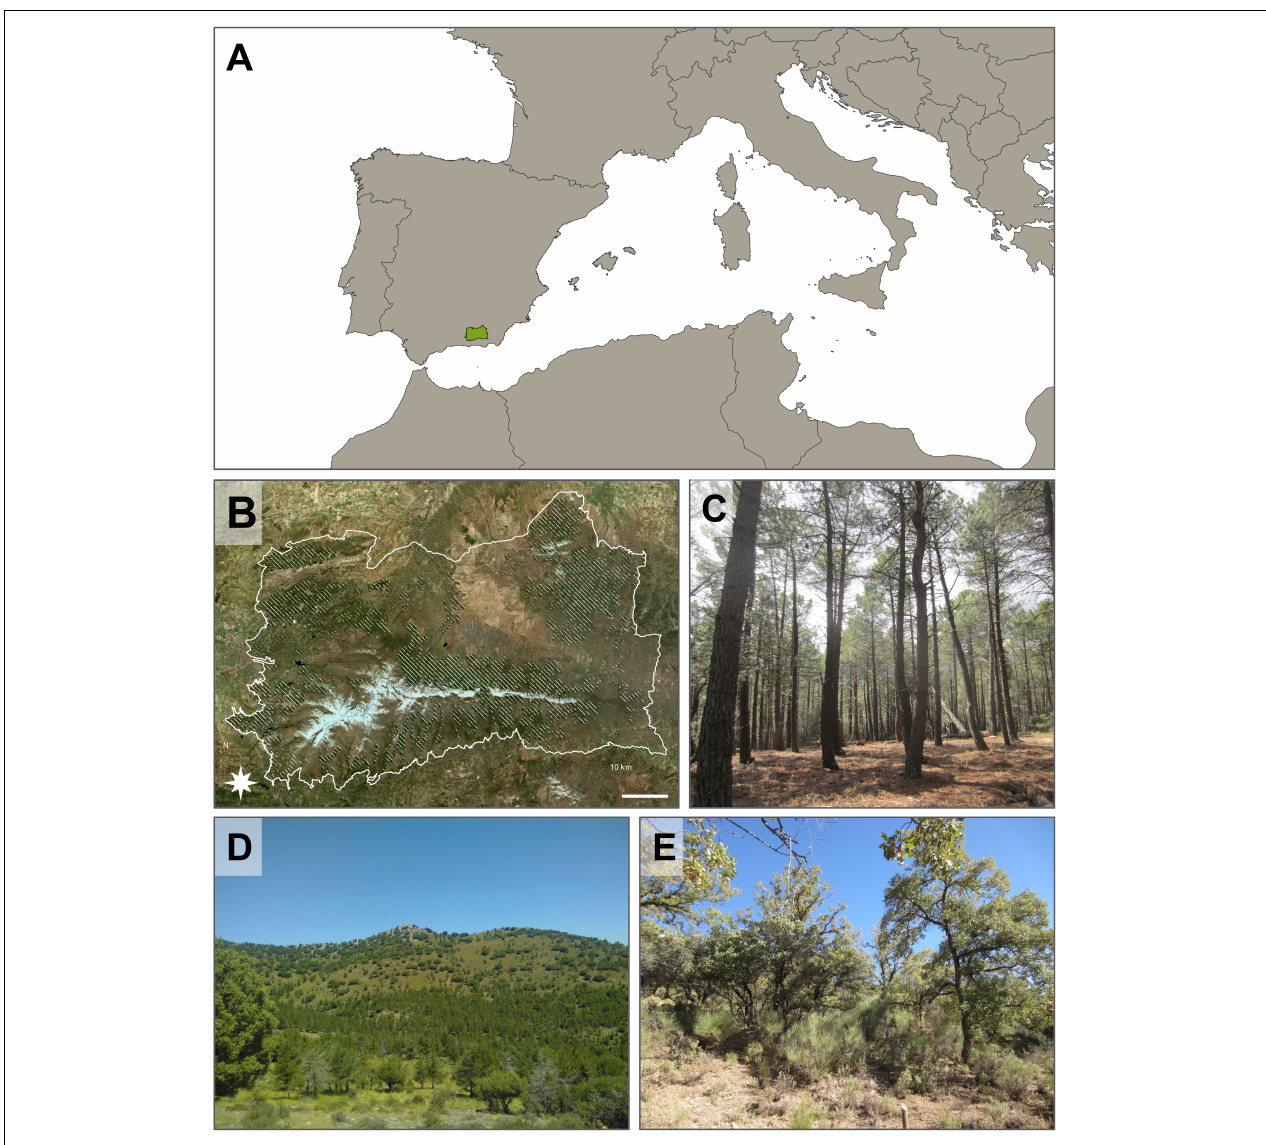
FIGURE 1 | Study area location (A) , orthophoto of the study area (B) and pictures of representative forest types: pine plantations (C) , mixed open forest (D) , oak-dominated stand (E) . Shaded area in panel (B) delimitates pine